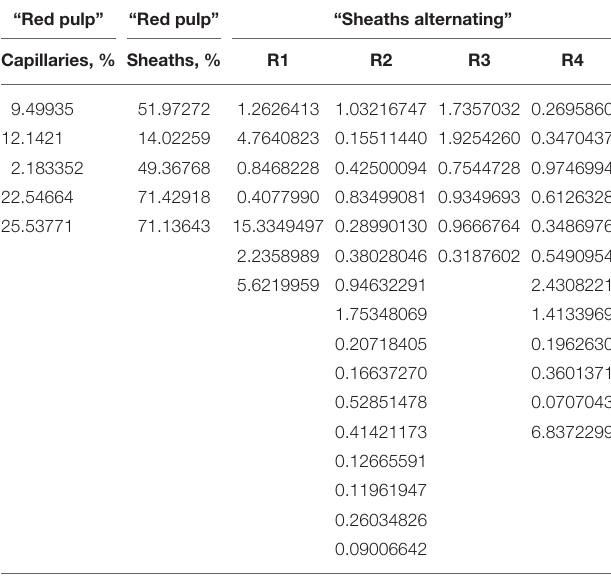
TABLE 2 | Percentage of the vertices highlighted in VR. “Red pulp” “Red pulp” “Sheaths alternating” Capillaries, % Sheaths, % R1 R2 R3